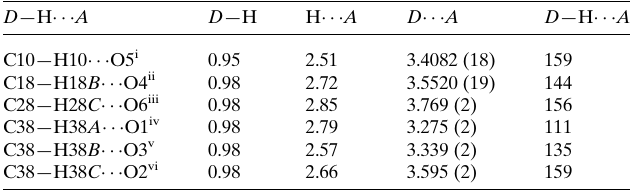
Table 1 Hydrogen-bond geometry (A˚ , (cid:2)